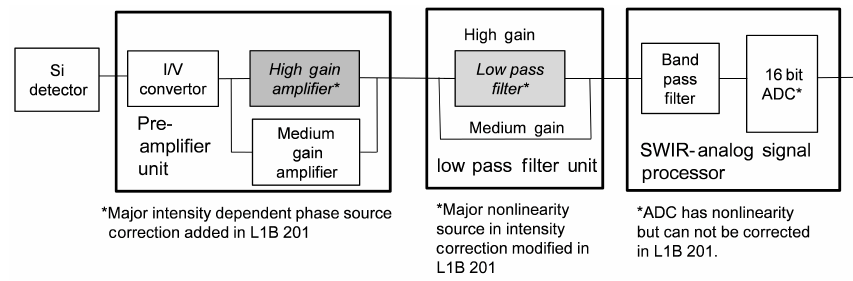
Figure 10. Band 1 analogue circuit block diagram and correction in L1B